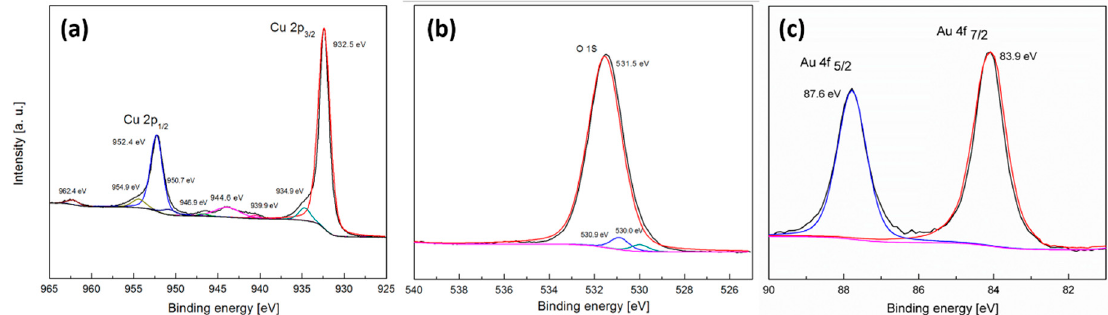
Figure 5. XPS spectra for ( a ) Cu 2p 3/2 , ( b ) O 1s and ( c ) Au 4f for a restructured Cu foil electrode galvanically replaced with gold via immersion in HAuCl 4 for 3 min (i.e., for the sample shown